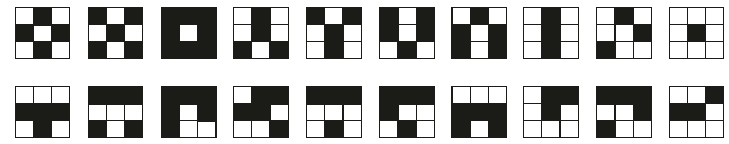
Figure 13: An example of PH i (first row) and PL i (2nd row) obtained from the Lena image.